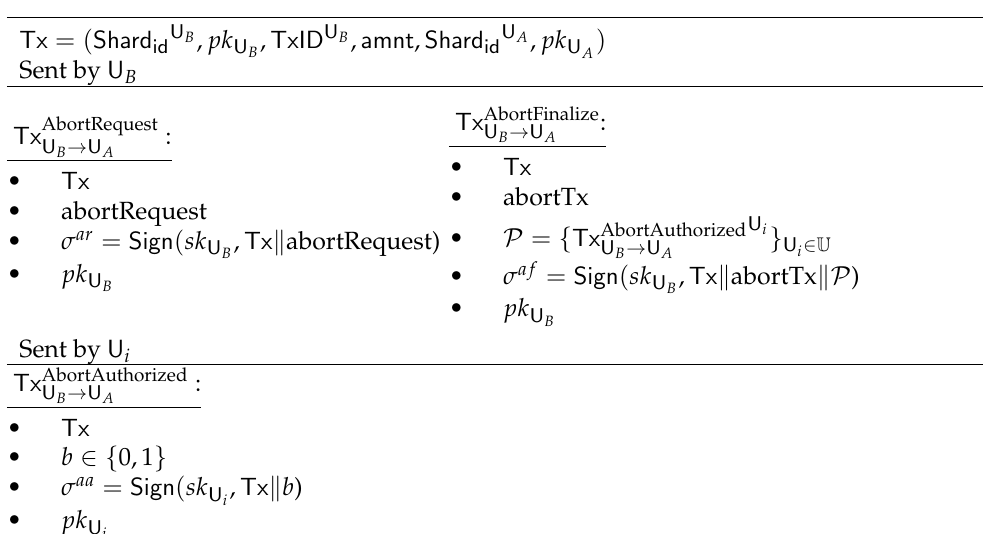
Figure 6. The Dandelion abort transaction message flow.